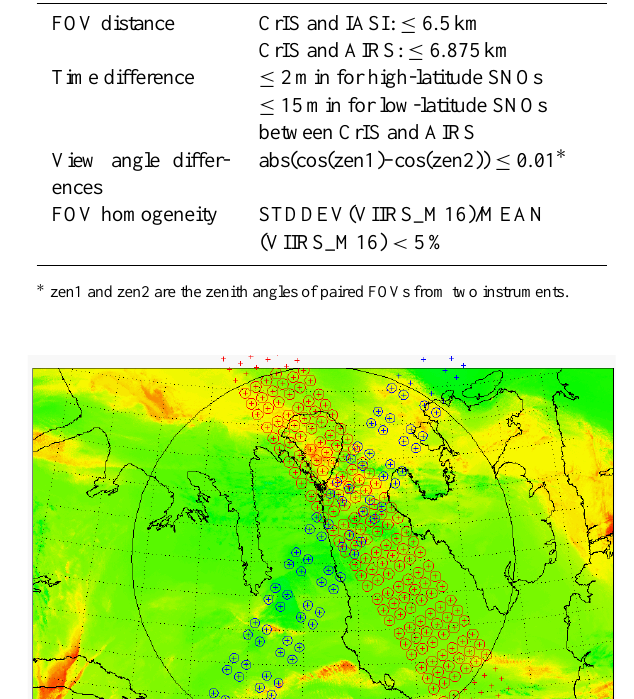
Figure 4. AIRS (top ) and CrIS (bottom) images at 900.0cm − 1 for the polar ( (a) ) and tropical SNO ( (b) ) case, which occurred at 21:49 and 16:15UTC on 30 August 2013, respectively. The black plus symbols indicate their orbital crossing positions. The BT val- ues range from 185 (black) to 305K